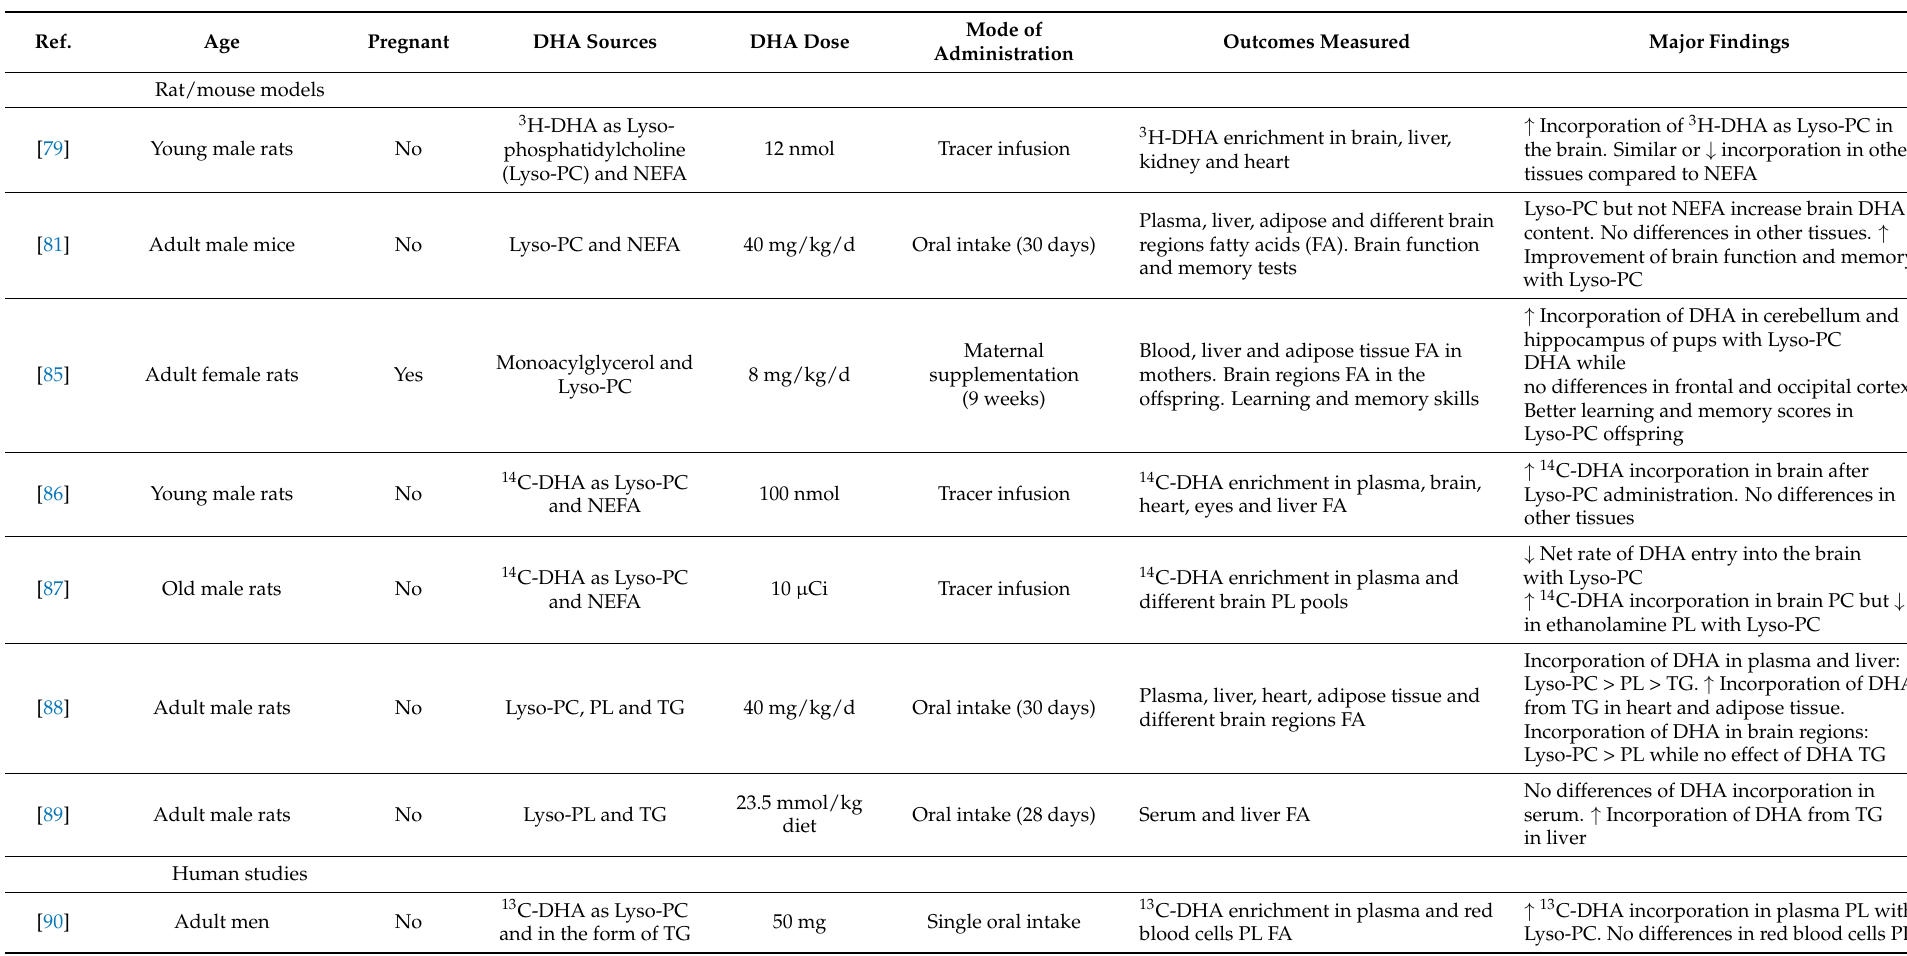
Table 1. Studies evaluating docosahexaenoic acid (DHA) bioavailability using Lyso-Phospholipids (Lyso-PL) respect to other chemical forms.